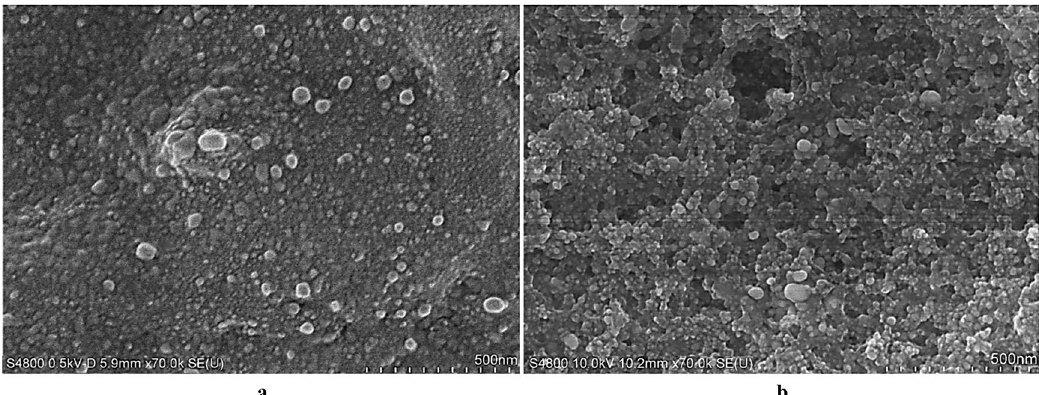
Figure 7. SEM images of AgNPs (AgNPs was synthesized under the optimal conditions at 28 °C in the dark for 6d, Ag + concentration is 10 mM, and adjust the pH of HX-YS treated AgNPs solutions to 6.0, LPP-12Y is 5.0)